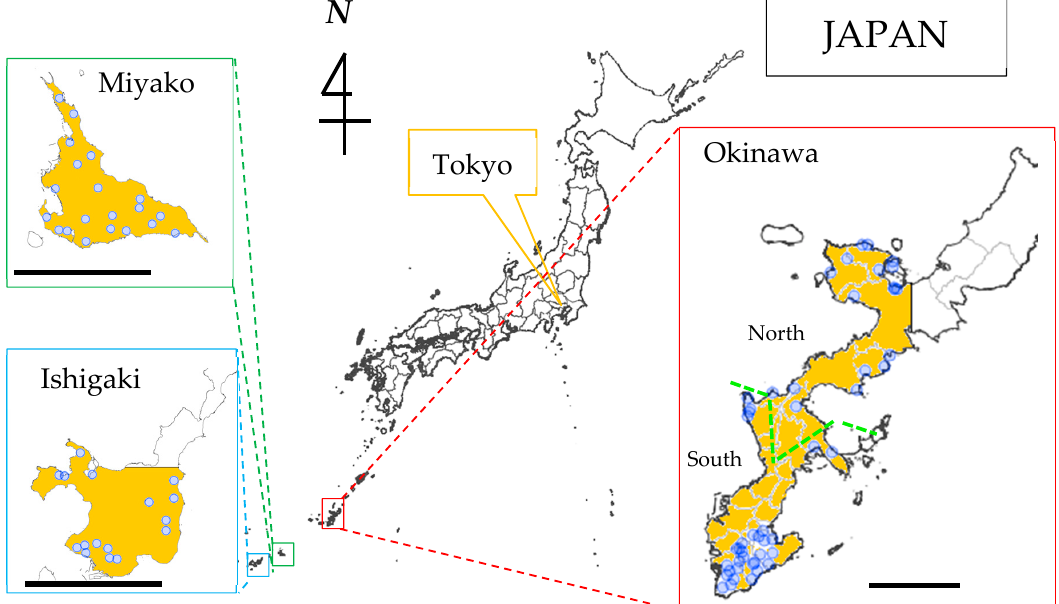
Figure 1. Soil sampling sites in each island. The green dotted line in the Okinawa map (enlarged) is to separate North and South. The scale bar at the bottom of each island is approximately 20 km. The maps are based on the blank map [21] published by Geospatial Information Authority of Japan [22] and developed using leaflet package in R.